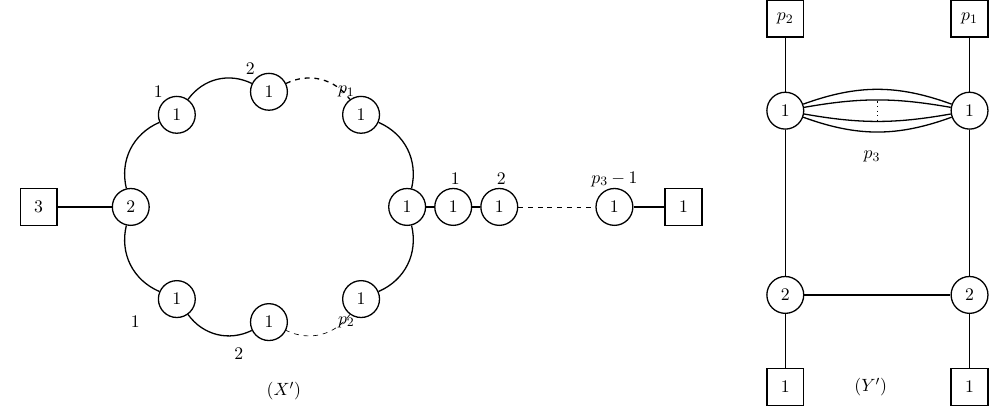
Figure 23 . An infinite family of mirror duals labelled by the positive integers ( p 1 , p 2 , p 3 ) subject to the constraints p